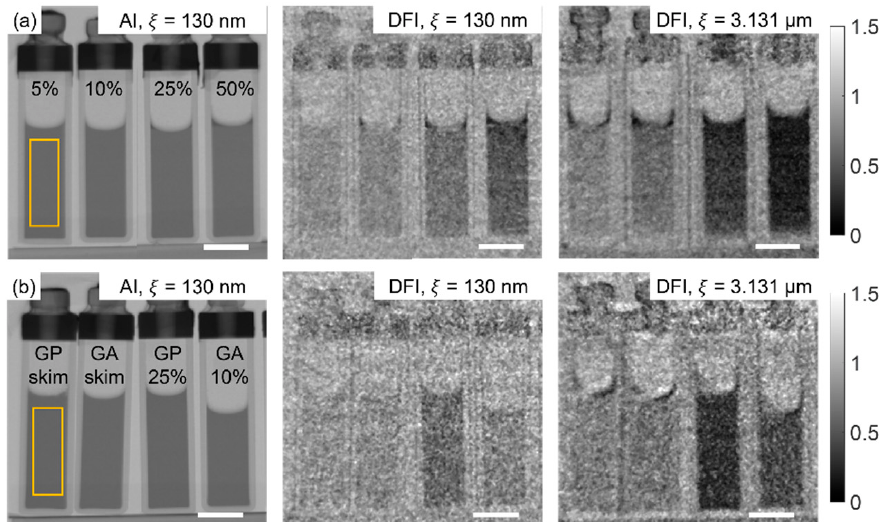
Figure 4. ( a ) Attenuation contrast image (AI) and dark-field images (DFI) of deuterated milk samples with different volume fractions of fat at probed correlation lengths of 130 nm and 3.131 μ m; ( b ) Attenuation contrast image (AI) and dark-field images (DFI) of milk gel samples at probed correlation lengths of 130 nm and 3.131 μ m; scale bar is 10 mm.